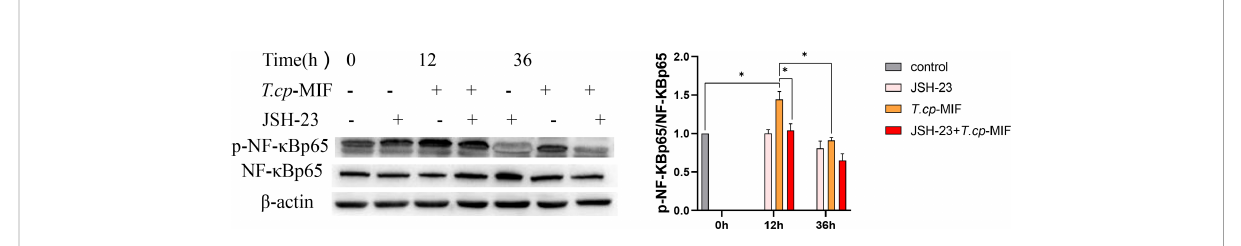
FIGURE 12 The effect of JSH-23 on the expression of macrophage polarization-related proteins. The cells were pretreated with JSH-23 (the NF- k B inhibitor) for 12 h, and the expression levels of NF- k Bp65 and p-NF- k Bp65 were detected by western blot. * indicated P <0.05. Results are showed as the mean of three times of independent experiments ( x ̄ ±SD,